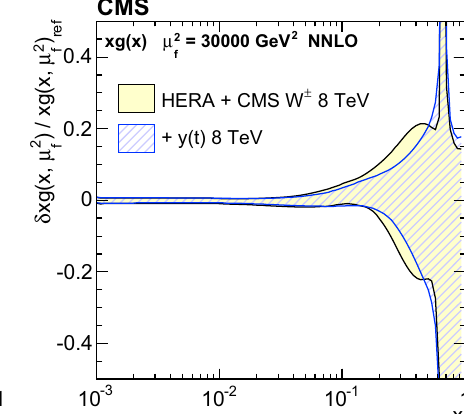
to the results from the fit using the DIS and W ± boson charge asym- metry data only. The total uncertainty of each distribution is shown by a shaded (or hatched )